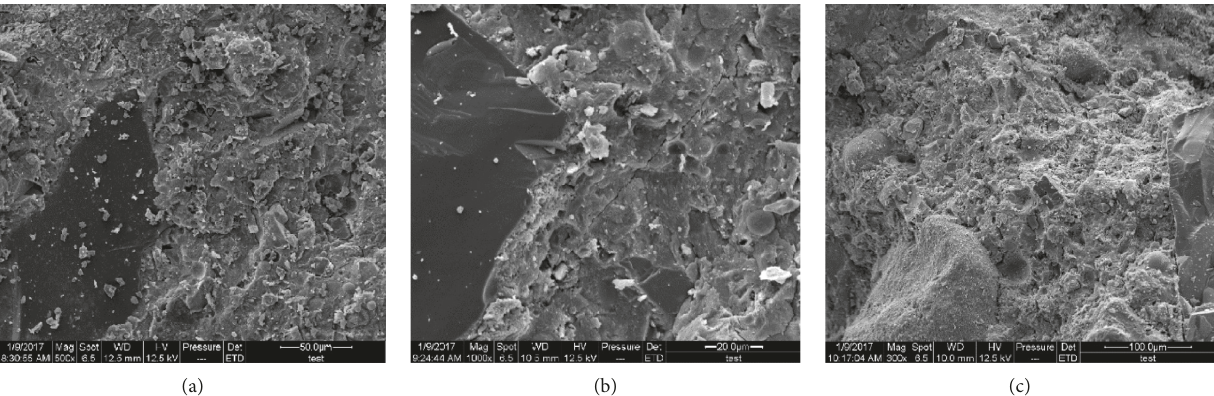
Figure 13: Microstructure evolution under dry oven conditions of specimens cured at 50 ° C. (a) Dry oven W/B=0.3. (b) Dry oven W/B=0.35. (c) Dry oven W/B =0.4.